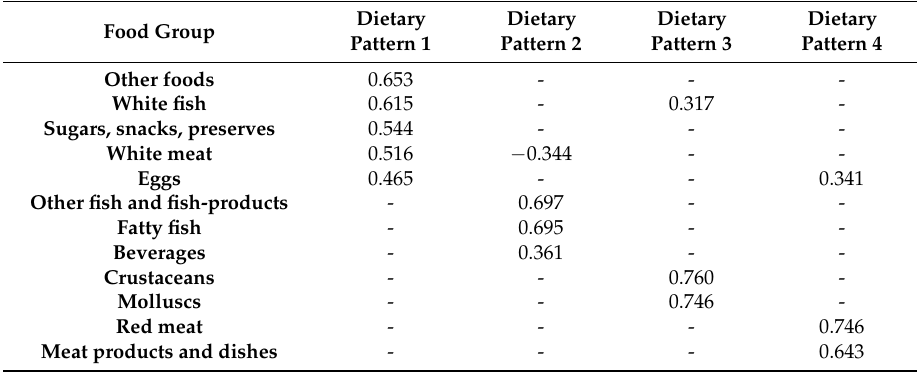
Table 3. Factor loadings for dietary patterns identified by principal component analysis (PCA) for n = 268 (plausible reporters